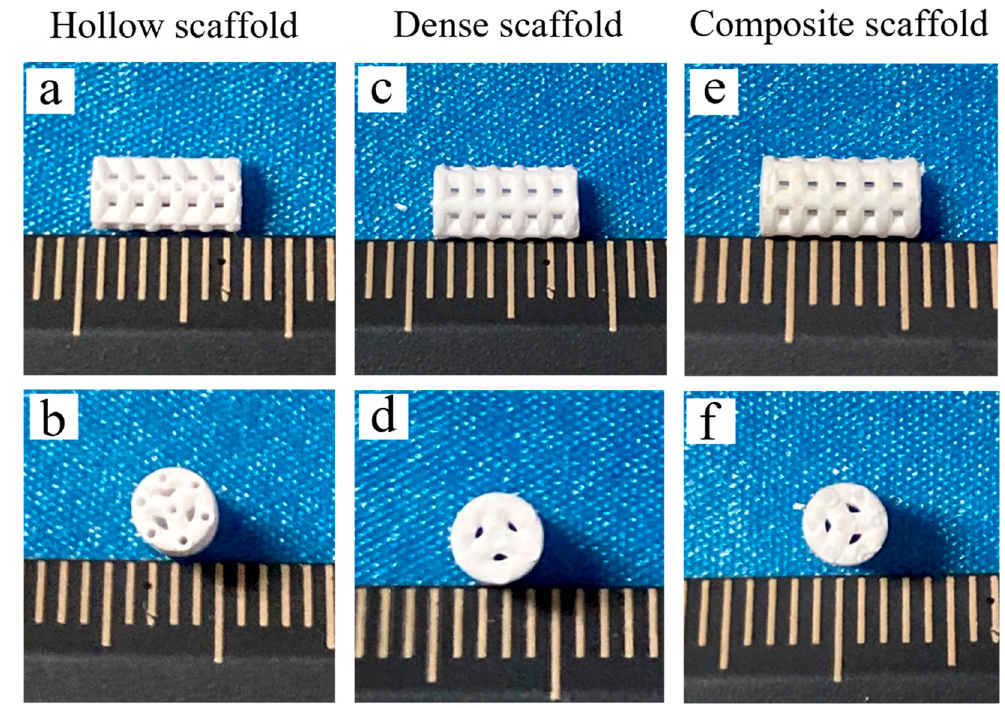
Figure 6. Photographs of β -TCP ceramic scaffolds fabricated by the DLP process: ( a , b ) hollow scaffolds, ( c , d ) dense scaffolds, ( e , f ) composite scaffolds fabricated by the infiltration process.